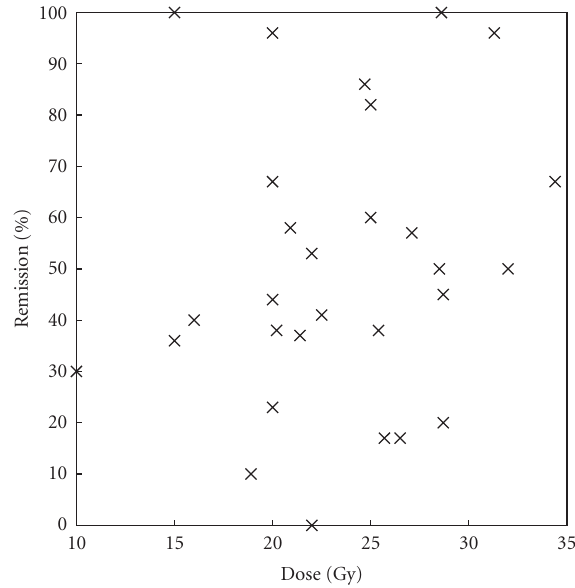
Figure 1: E ff ect of GKS dose on remission. The percentage of patients in remission is plotted as a function of the dose used during GKS. There is no significant trend, though the heterogeneity of the studies makes it di ffi cult to draw definite conclusions.